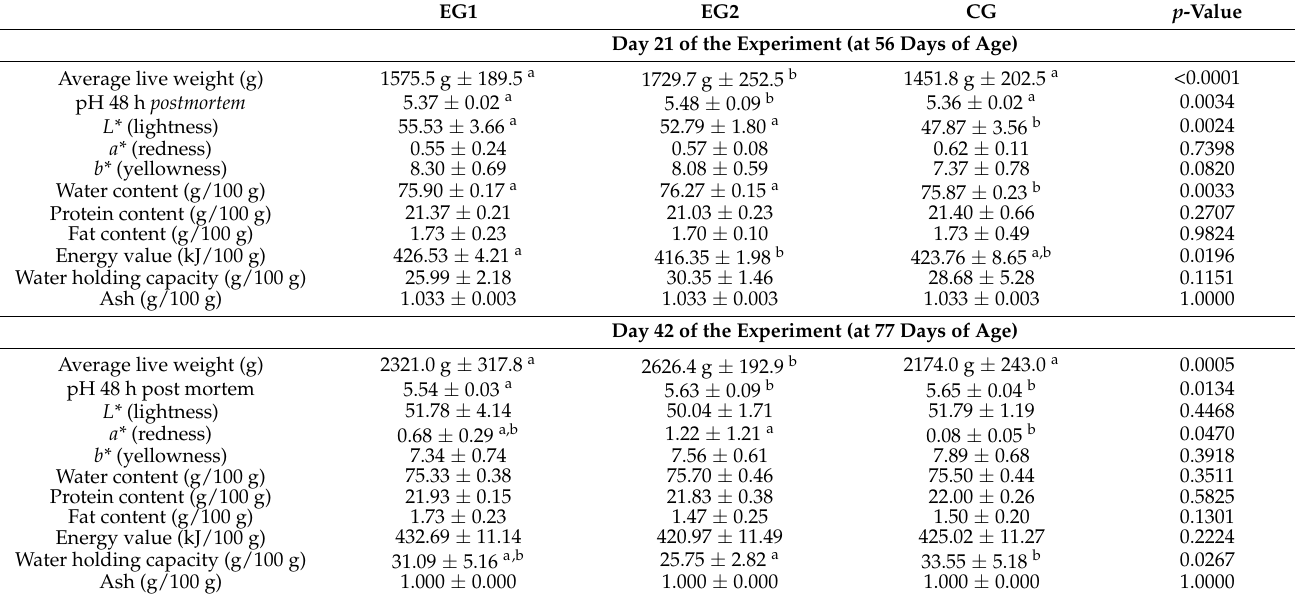
Table 3. Physicochemical properties of Longissimus thoracis and lumborum of rabbits (means ±